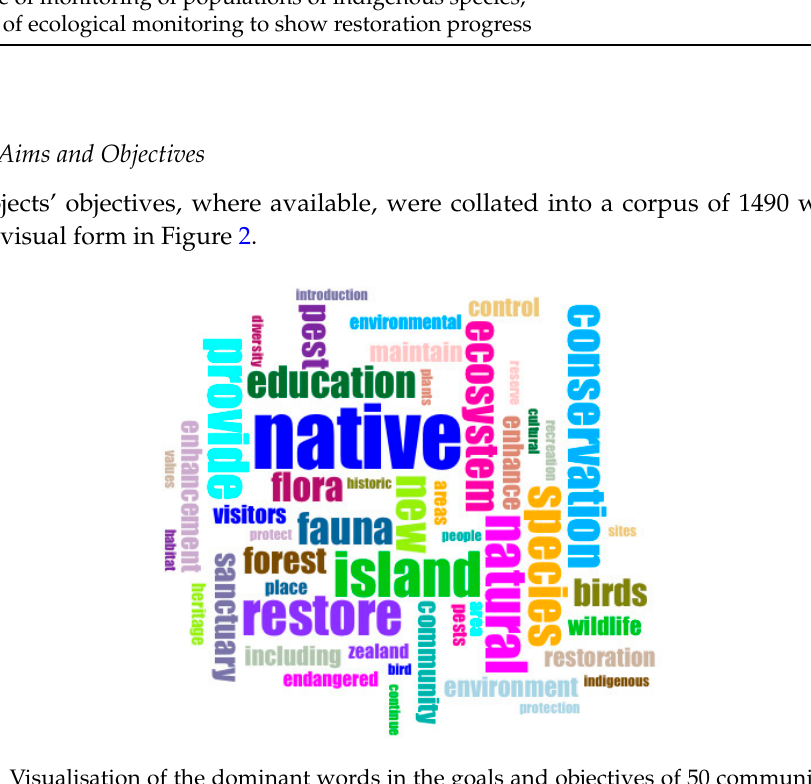
Table 3. Top 10 key words and top 2 multi-word expressions from community groups’ aims and objectives aligned with attributes of restored ecosystems.